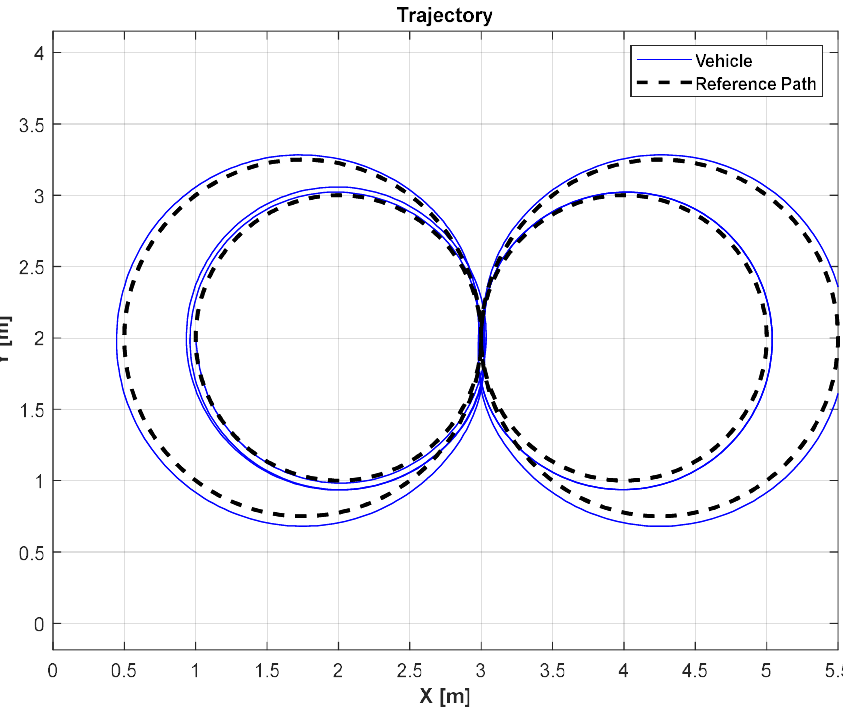
Figure 12. Trajectory of the vehicle during the drift-driving simulation.